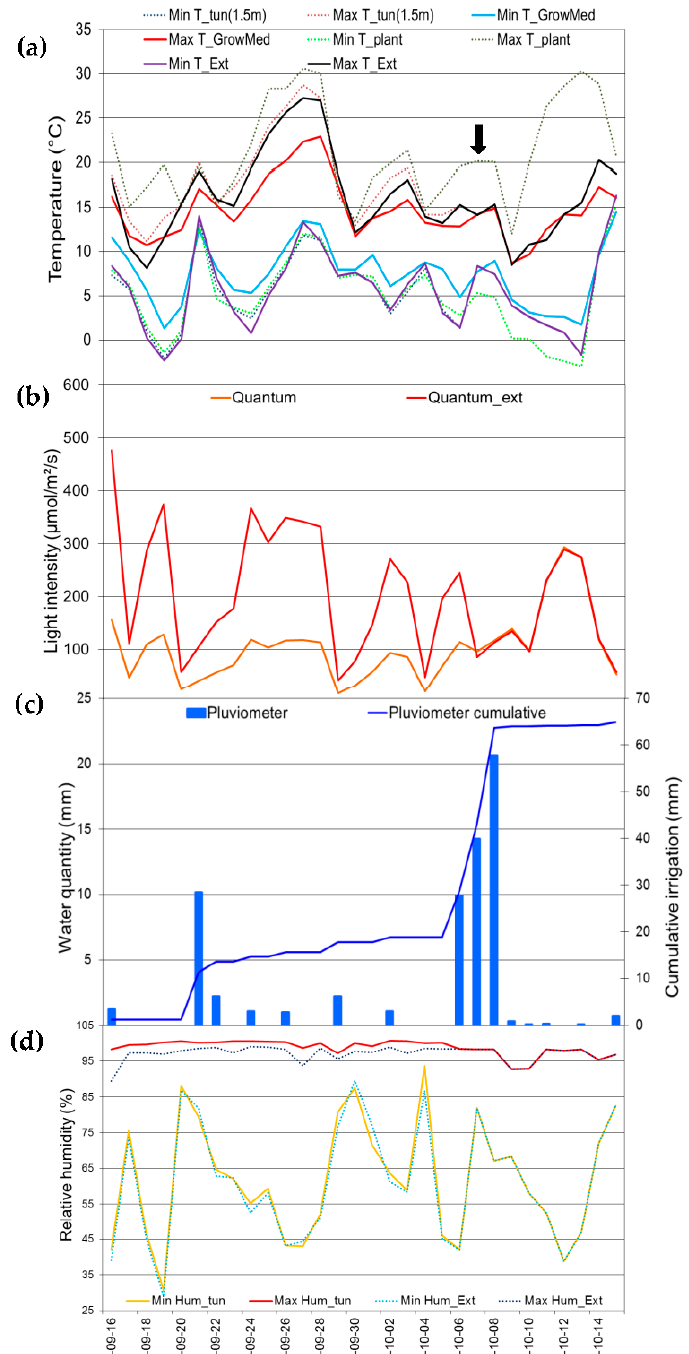
Figure 6. Environmental data covering the exposition time of the sensors to forest nursery conditions including ( a ) maximum (Max T_) and minimum (Min T_) temperature inside (tun(1.5 m)) and outside (Ext) the tunnel, and at the surface (plant) and in the rhizosphere of the substrate (GrowMed); ( b ) the light exposition inside (Quantum) and outside (Quantum_ext) of the tunnel; ( c ) irrigation on a daily basis and cumulative; and ( d ) minimum (Min Hum_) and maximum (Max Hum_) relative humidity for inside (tun) and outside (Ext) the tunnel. The black arrow indicates the date of the removal of the tunnel coverage corroborated by the superposition of many data points from inside and outside.